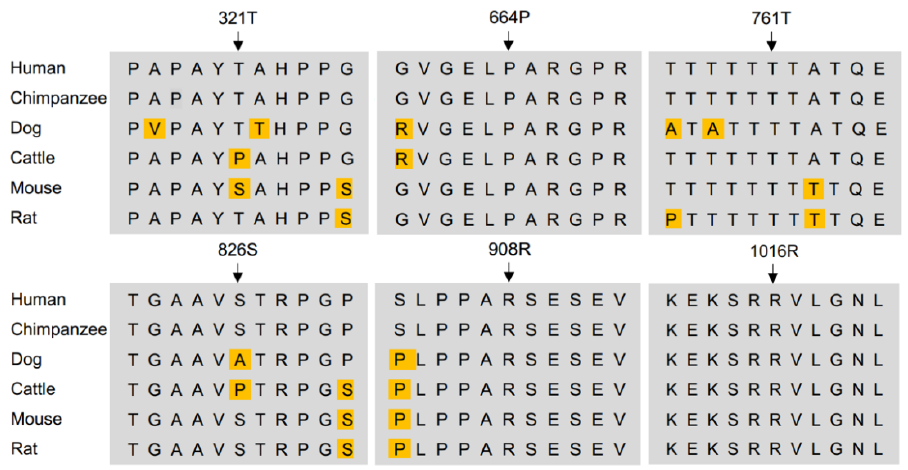
Table 1. Clinical features of patients with KDM6B variants.